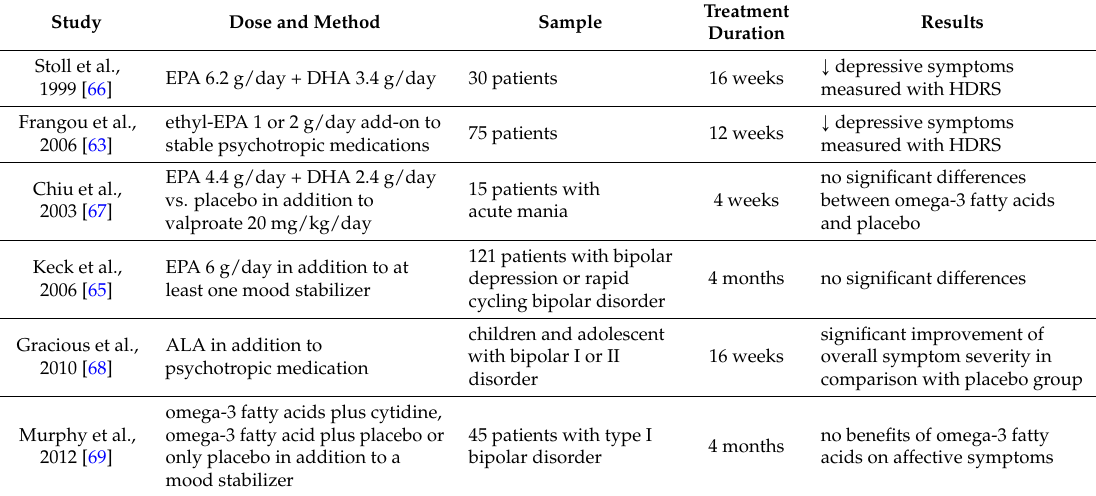
Table 3. Double-blind controlled trials of HUFAs in the treatment of bipolar disorders (depressive and maniac